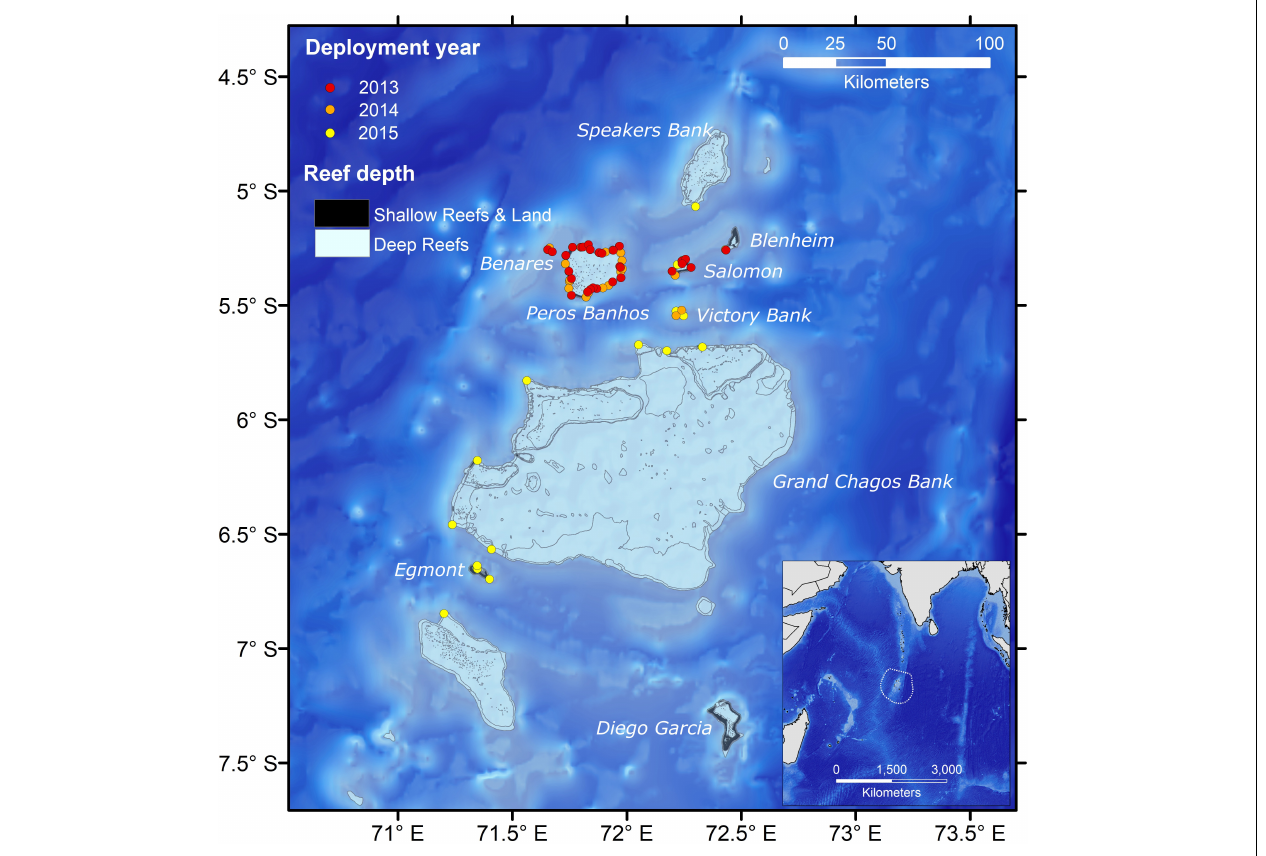
FIGURE 1 | Acoustic array in the BIOT MPA showing year of deployment for acoustic receivers. The inset shows the location of the BIOT MPA with the extent of the MPA being shown by the dotted line. Shallow reefs are < ∼ 20 m, deep reefs are ∼ 100 to 20 m in depth. Gray lines show contours of major submerged features. Note that there is little land in the